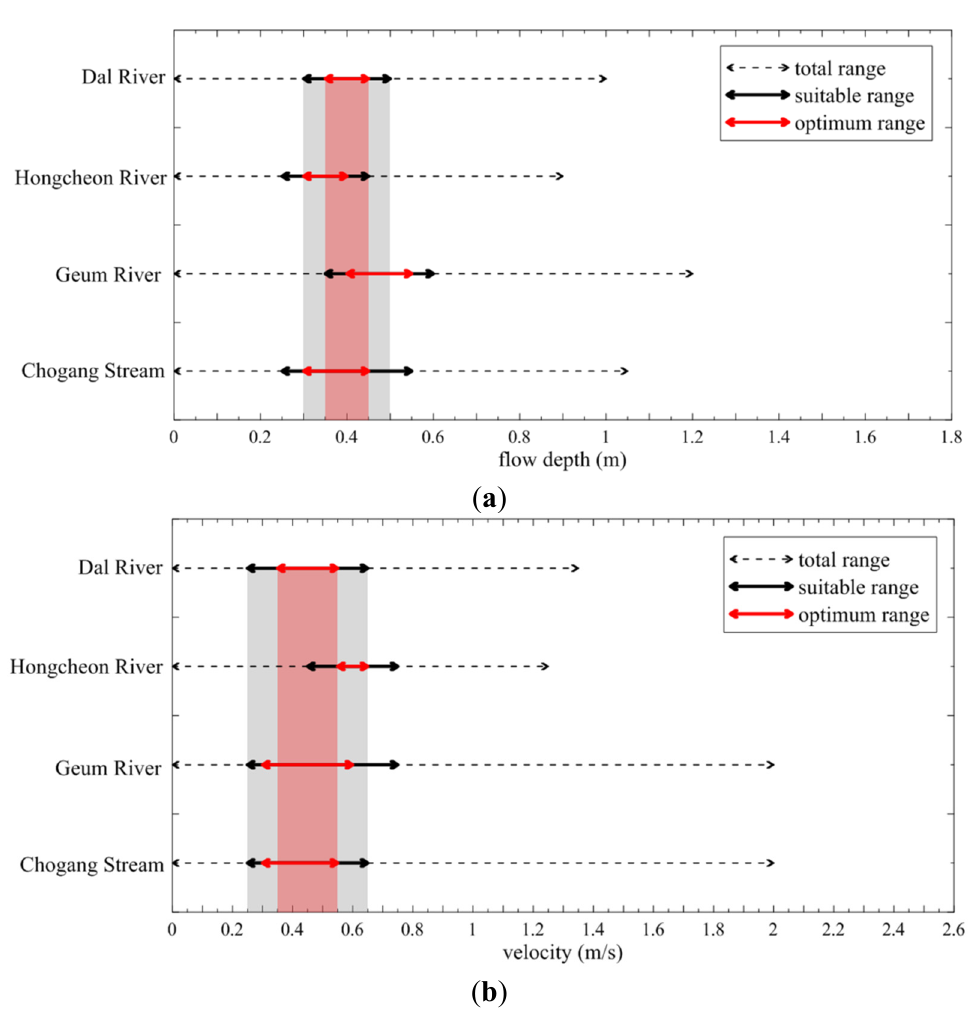
Figure 2. ( a ) Flow depth; ( b ) velocity. Suitable range and optimum range of